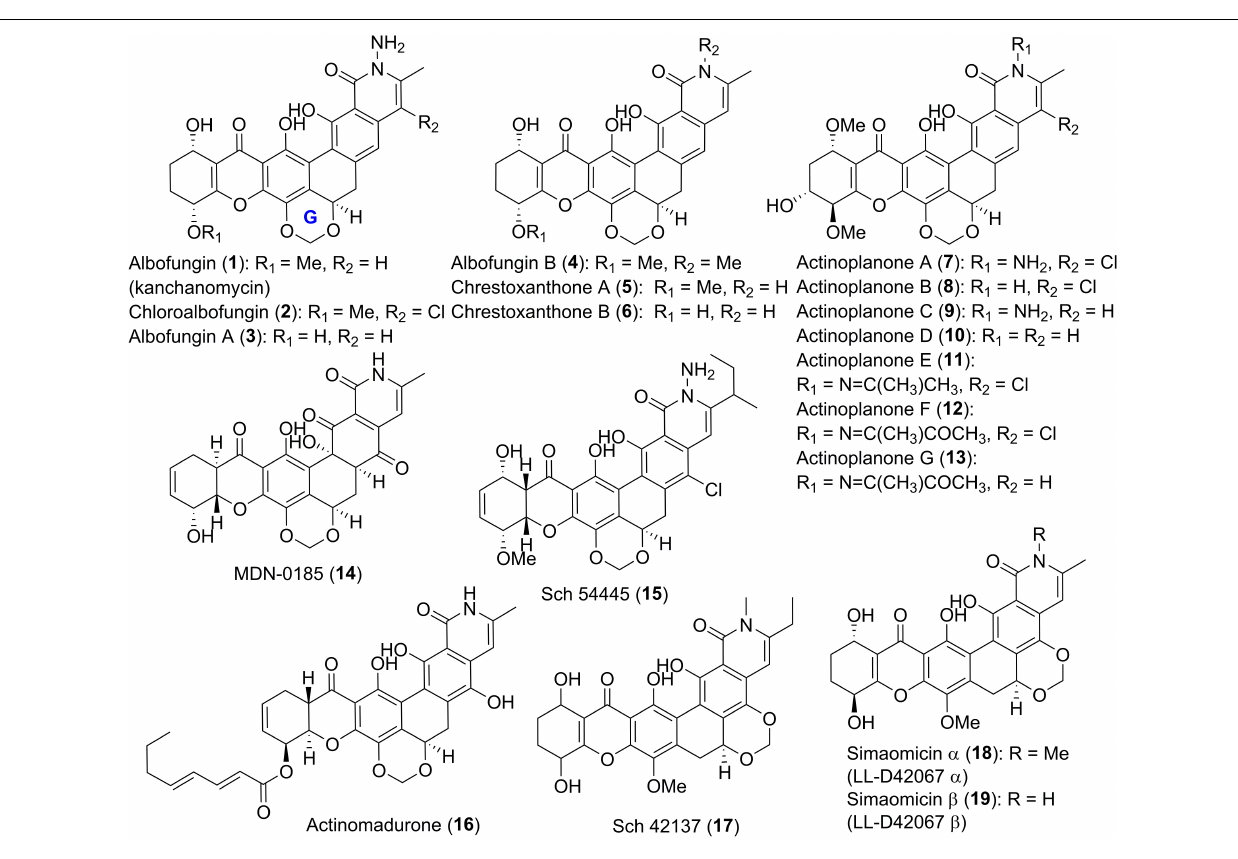
FIGURE 2 | Chemical structures of compounds 1–19